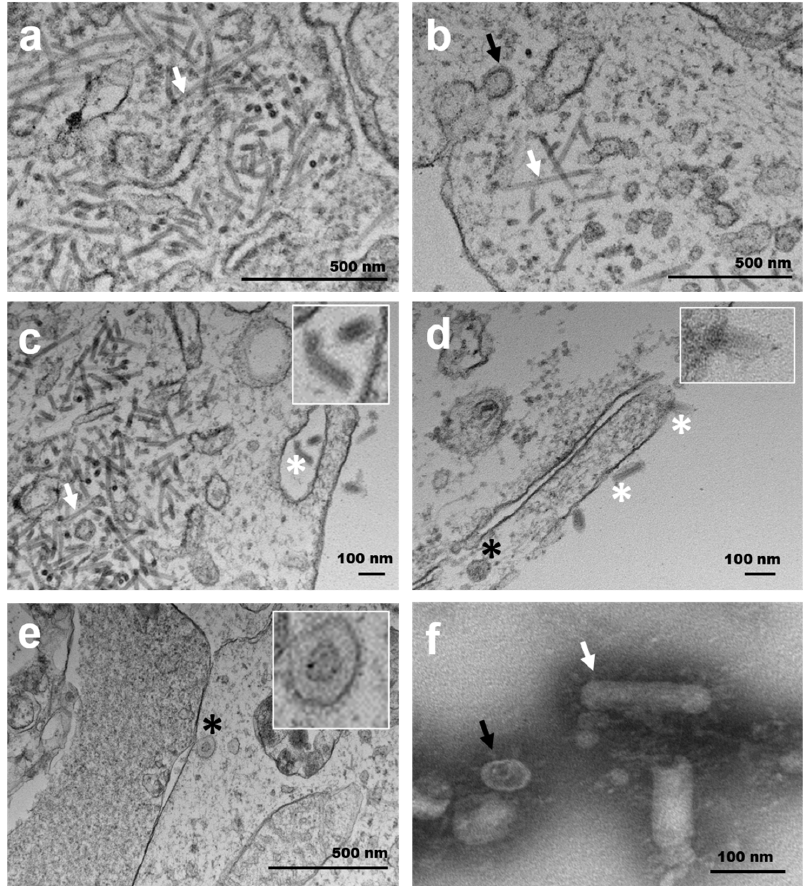
Figure 5. Transmission electron micrographs of FHM ( a , b ) and E11 cells ( c – f ) cells inoculated with chinook salmon bafinivirus Cefas-W054 isolate. ( a – c ) Spherical (black arrows) and bacillary (white arrows) viral nucleocapsids were observed within the cytoplasm of these cells. ( c – e ) Mature enveloped spherical (black asterisks) and bacillary virions (white asterisks). Top inserts show the detail of mature virions with spikes on the surface. ( f ) Transmission electron (negative staining) of purified virions from the E11 cell supernatant. The external surface of spikes can be seen surrounding spherical (black arrows) and rod-shaped (white arrows)